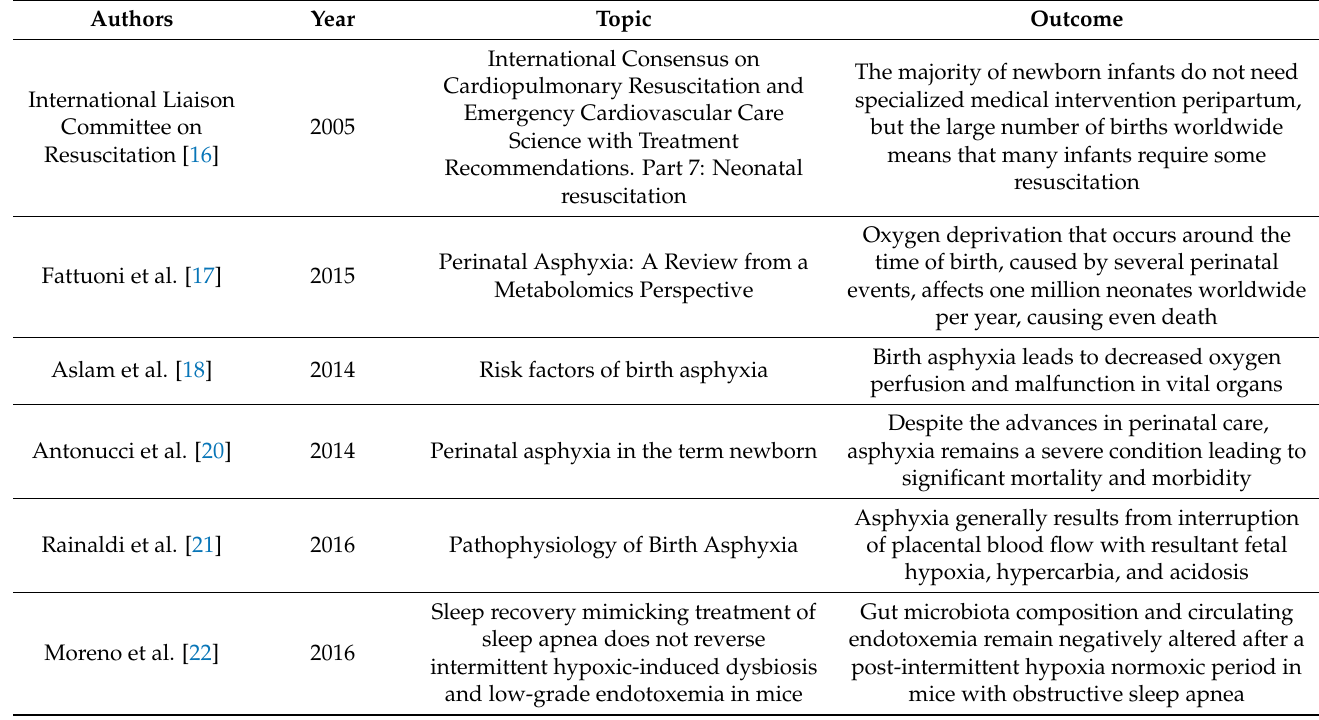
Table 2. Systemic research results for Microbial Translocation in Neonatal Hypoxic/Asphyxiating